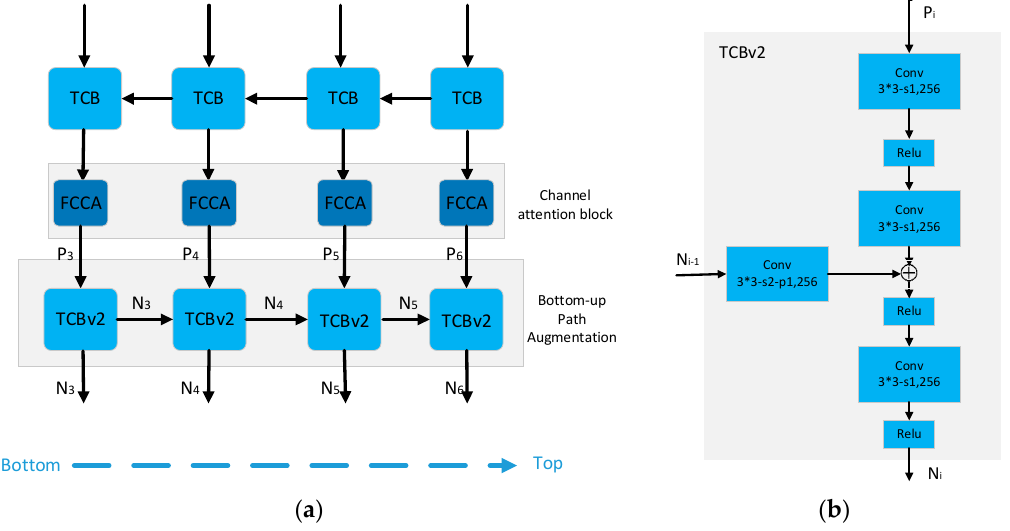
Figure 5. The structure of BA-TCB. ( a ) Bidirectional structure (Top-down TCB and Bottom-up TCBv2); ( b ) The structure of TCBv2.